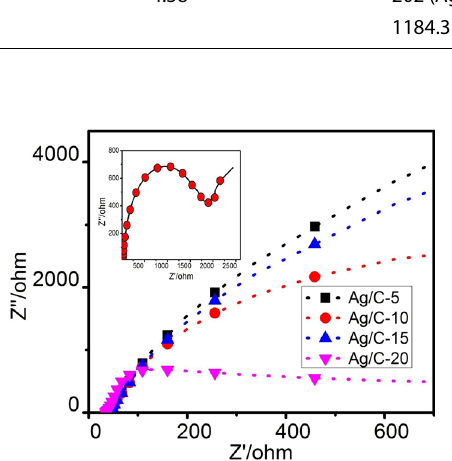
solution on all Ag/C modi- 4